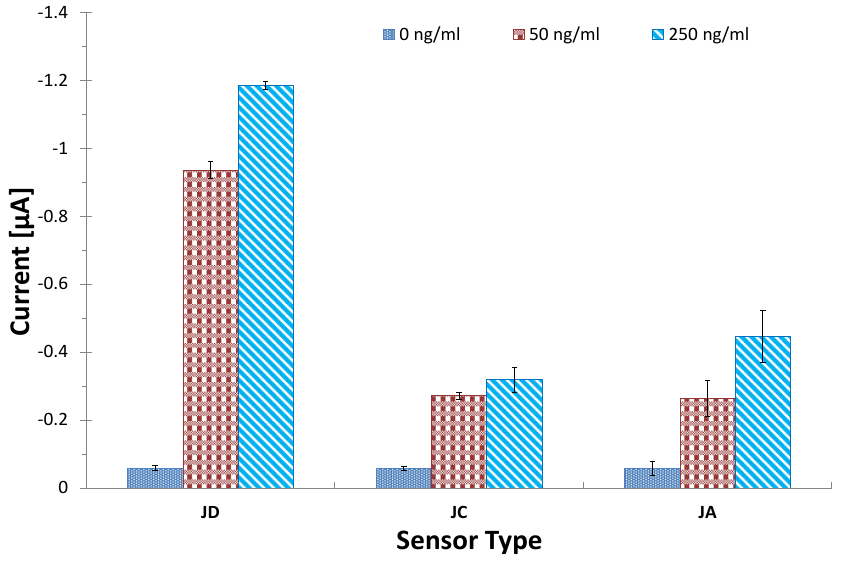
Figure 2. The performance of the JD, JC and JA screen-printed electrodes. Fifteen microliters of 50 µg·mL −1 of mouse monoclonal antibody against human CRP in 0.05 M carbonate bicarbonate buffer, pH 9.6, were immobilised on the working electrode by incubation for 1 h at 37 °C. HRP conjugated anti-CRP solutions, the equivalent of 5 µg·mL −1 premixed for 30 min with antigen solutions (0, 50, 250 ng·mL −1 in 1:40 milk solution in PBS), was added and incubated for 2 h at 37 °C after a washing step. Electrodes were connected to an analyser, and 100 µL of substrate solution were added before amperometric measurements were done at a potential of −200 mV, CV = 11.4%; the bars represent the standard error of the means (n =